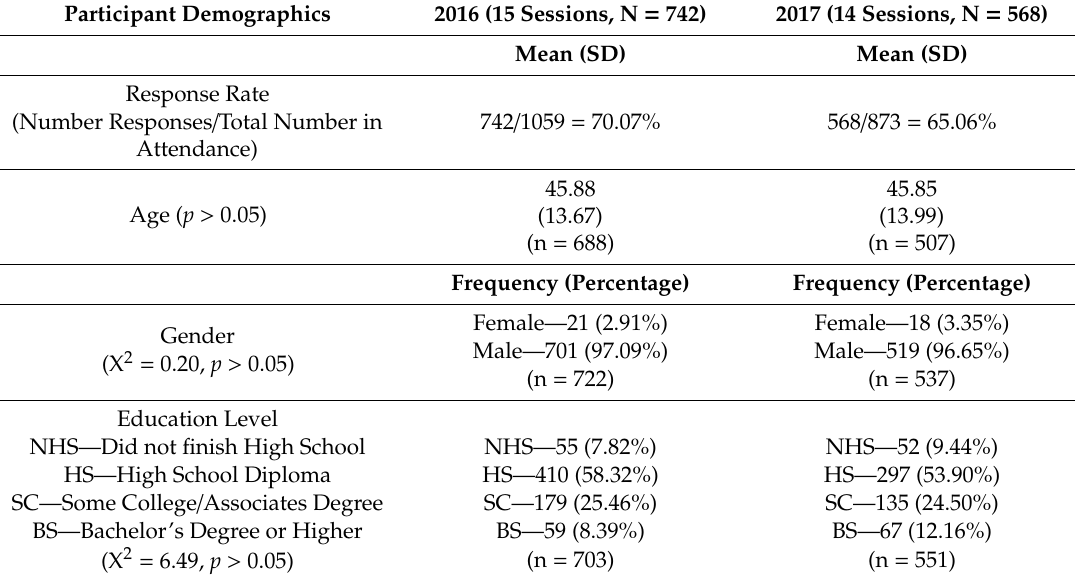
Table 1. Participant demographics in training survey: baseline (2016) vs. update